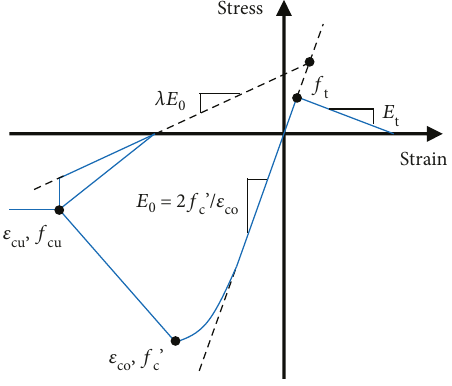
Figure 4: Model of concrete in OS